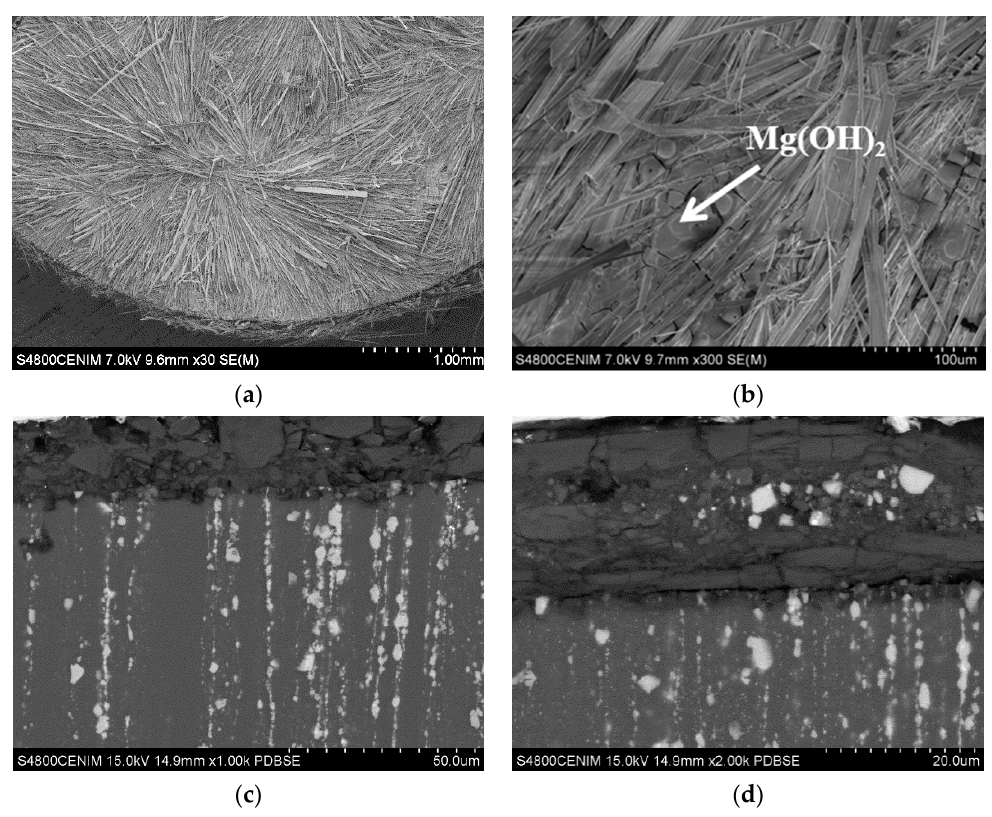
Figure 7. Secondary electron images of the surface condition of the corrosion scale formed on EZ51-IM350 alloy immersed in PBS solution. ( a , b ) 48 h, ( c , d ) 144 h.